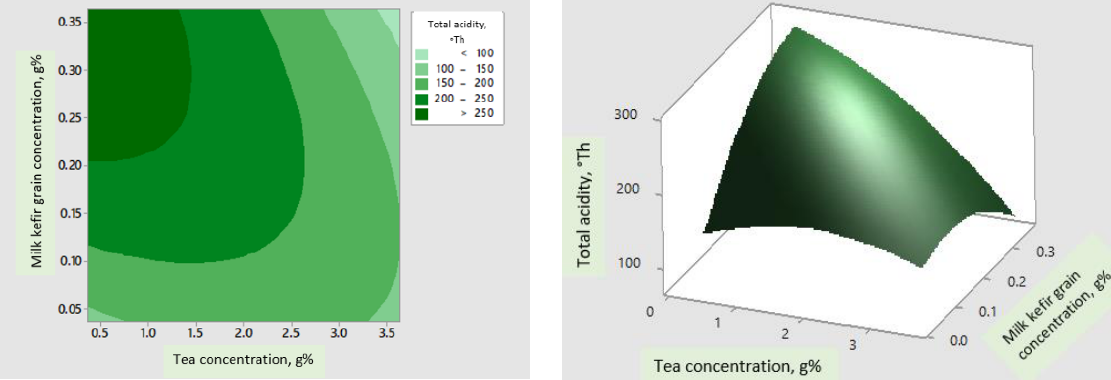
Figure 2. Contour ( left ) and surface plots ( right ) correlation effects between the milk kefir grains starter culture’s concentration and the tea concentration upon the TA.